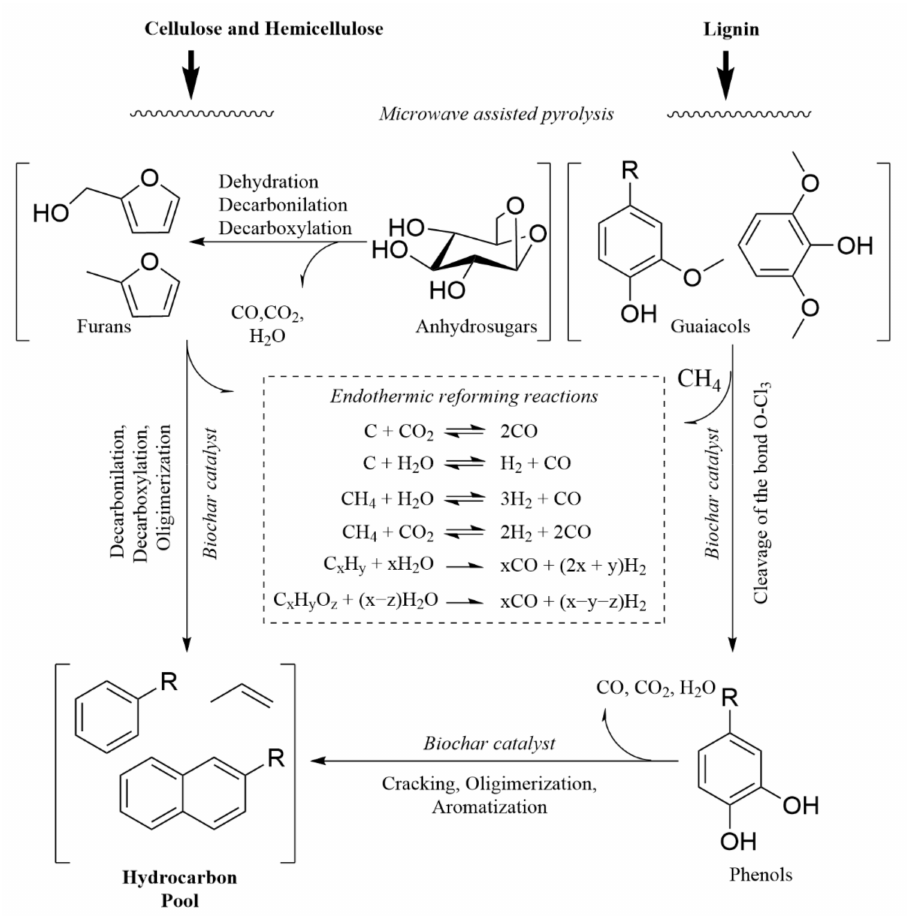
Figure 3. Possible pathway of hydrocarbon and syngas production from LB with biochar catalyst